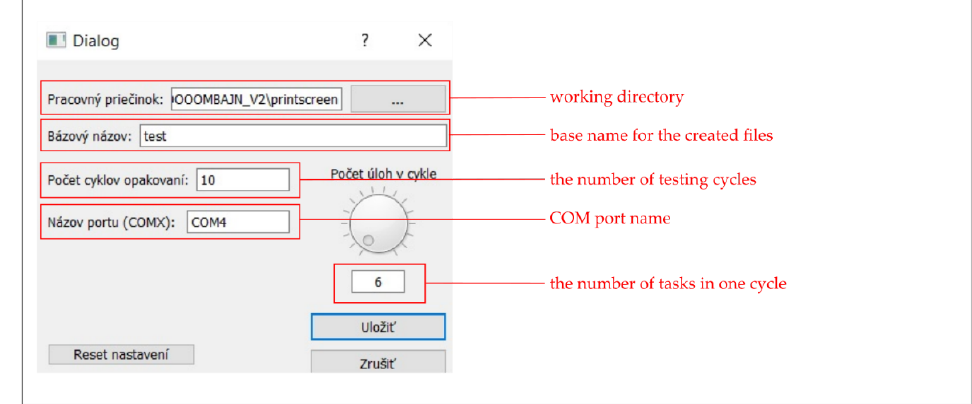
Figure 6. Settings window of the application for the testing device.